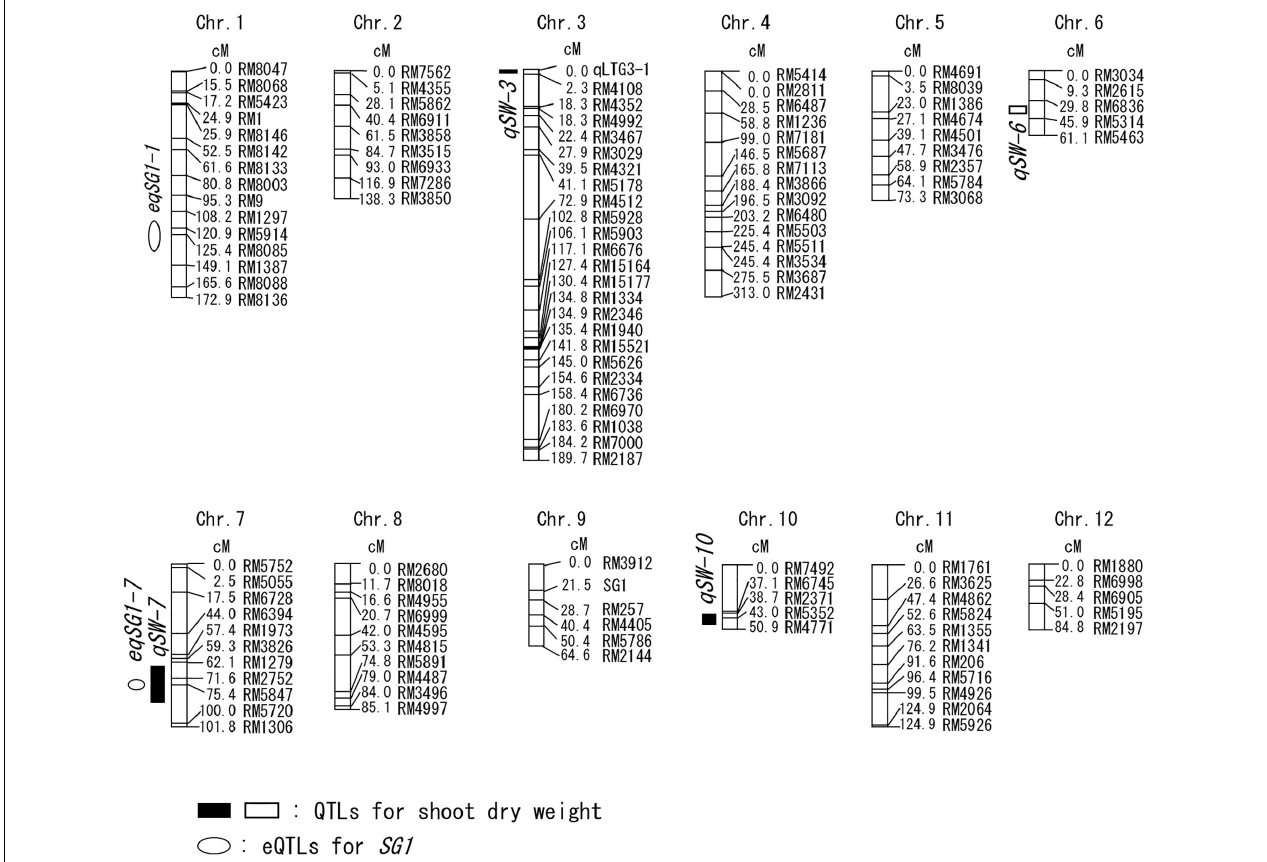
FIGURE 2 | Chromosomal locations of the QTLs for shoot dry weight and the expression QTLs (eQTLs) for short grain 1 ( SG1 ) gene. The black or white boxes indicate the positions of the QTLs for shoot dry weight. The white circles indicate the positions of the eQTLs for SG1 . The Ouu365 cultivar has the positive allele for the QTLs indicated by white symbols. The Arroz da Terra cultivar has the positive alleles for the QTLs indicated by black symbols. The names of markers and the genetic map position (cM) are represented on the right of the corresponding chromosome. The positions of qLTG3-1 and SG1 are indicated on chromosome 3 and 9, respectively.